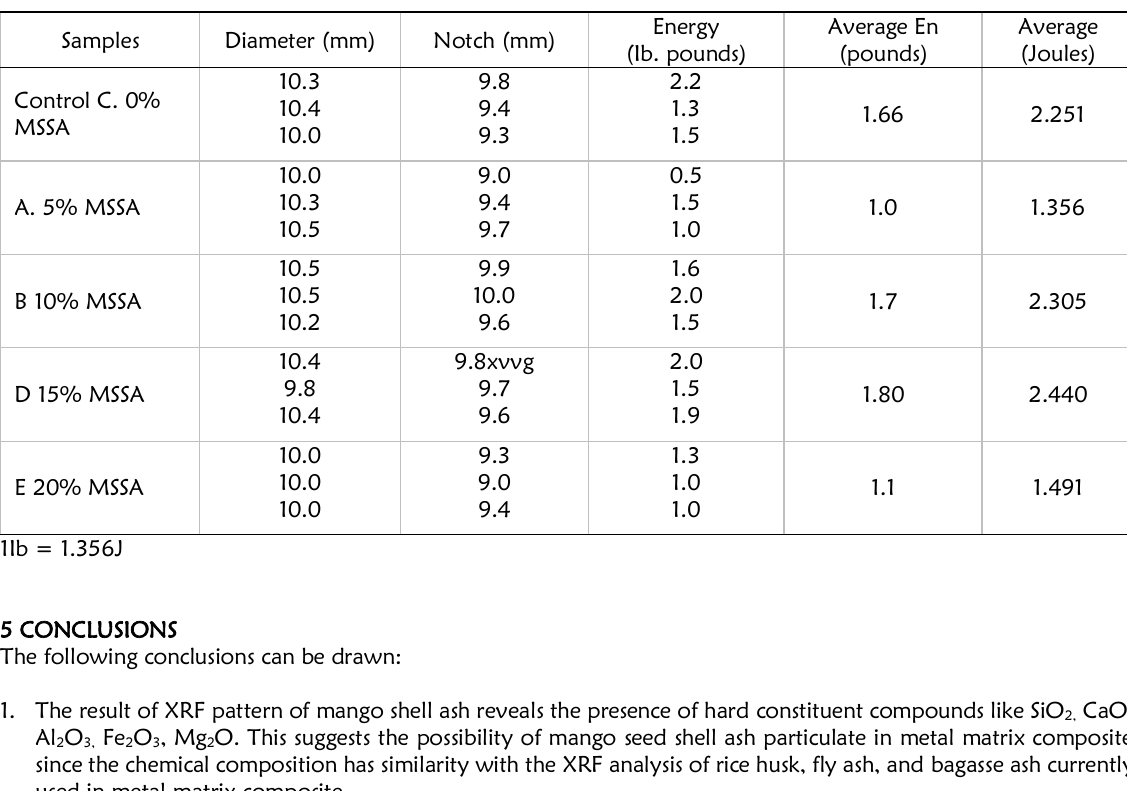
Table 8: Impact test